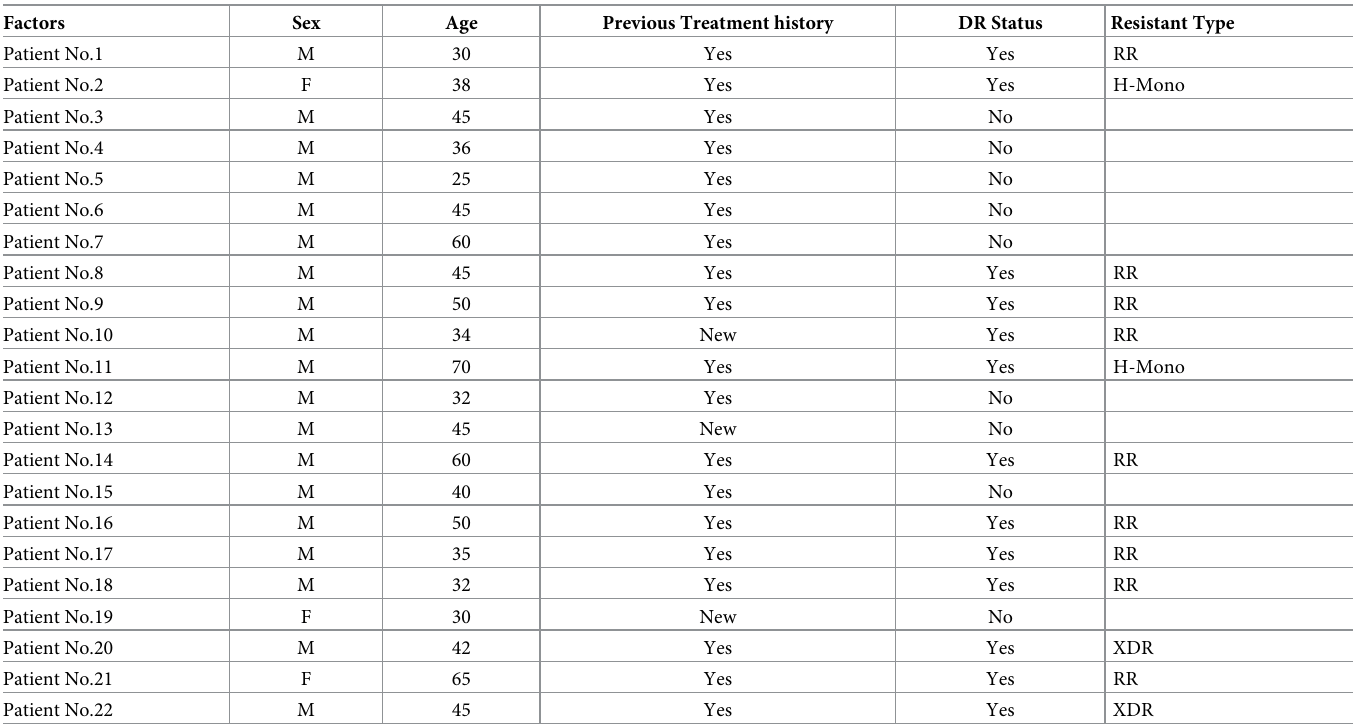
Table 1. Background information of patients (N =